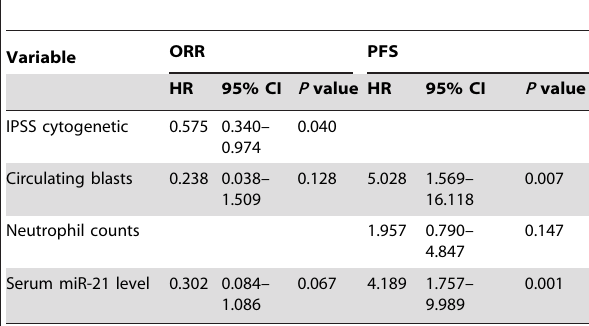
Table 4. Multivariate analysis for overall response to HMA and progression-free survival.